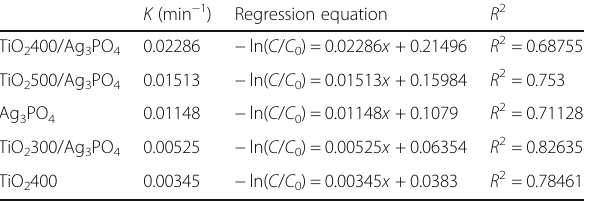
Table 1 Photo degradation rate constants and linear regression coefficients of different catalysts from equation − ln( C / C 0 ) =